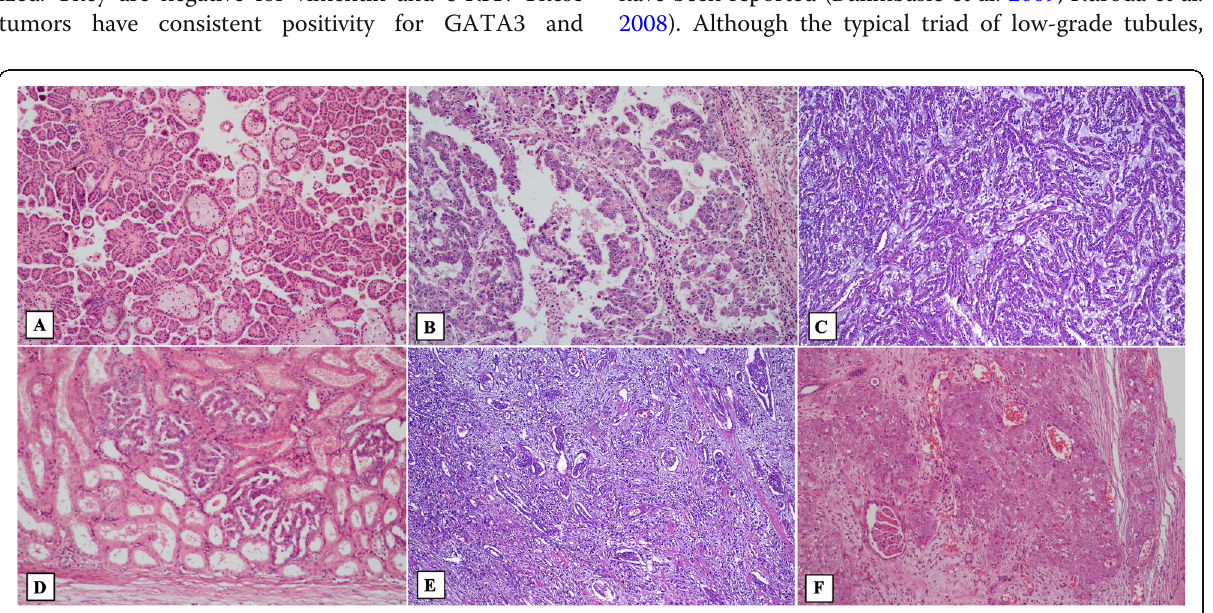
Papillary (with clear cells)